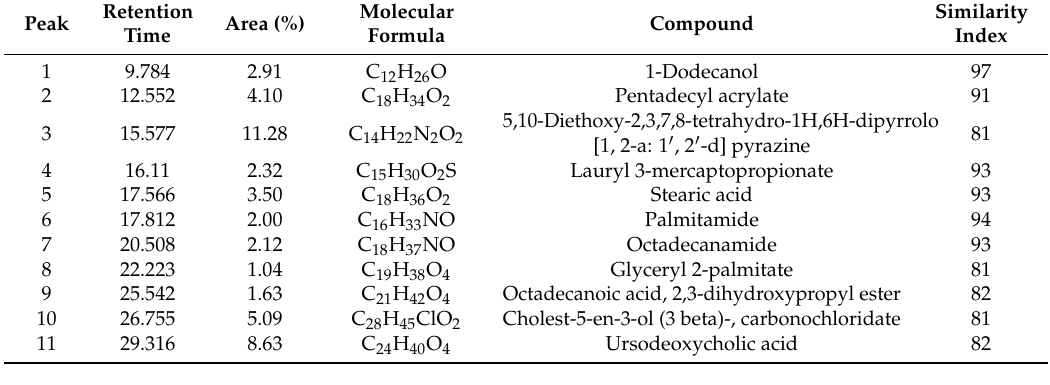
Table 2. GC-MS profile analysis of PB aqueous extract.